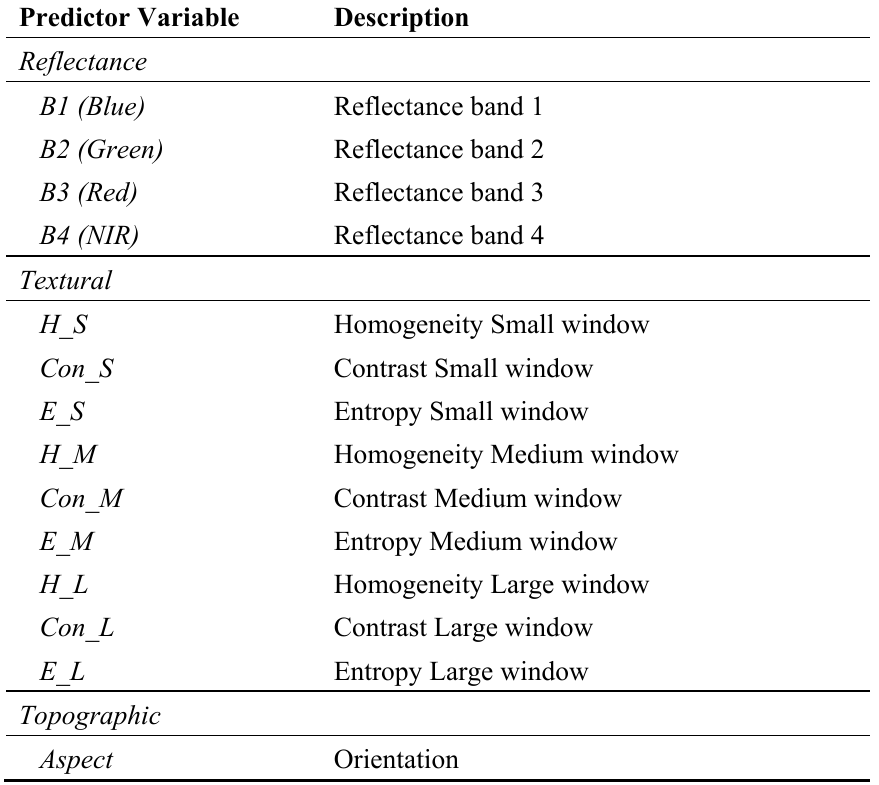
Table 3. Attributes used for modeling. The mean and standard deviation of each of these attributes was de facto used in the decision